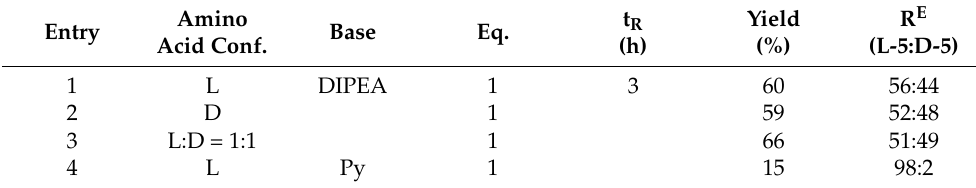
Figure 7. Synthesis of 2-acetamido-N,3-diphenylpropanamide ( 5 ) from N -Ac-phe and aniline. The coupling is mediated by TBTU. Table 5. Preparation of amide L-5 or D-5 from optically pure amino acids or their 1:1 mixture. Coupling is carried out using TBTU with 1 eq. of N,N -diisopropylethylamine or pyridine. t R = reaction